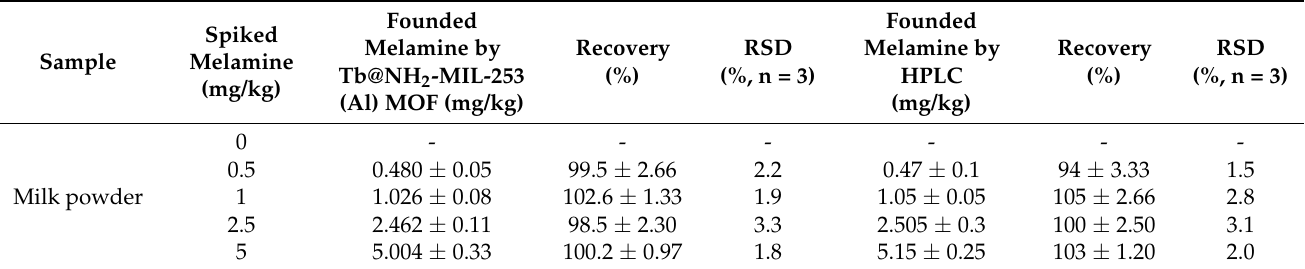
Table 2. Application of the proposed Tb@NH2-MIL-253 (Al) MOF sensing platform and HPLC for the detection of melamine in milk powder